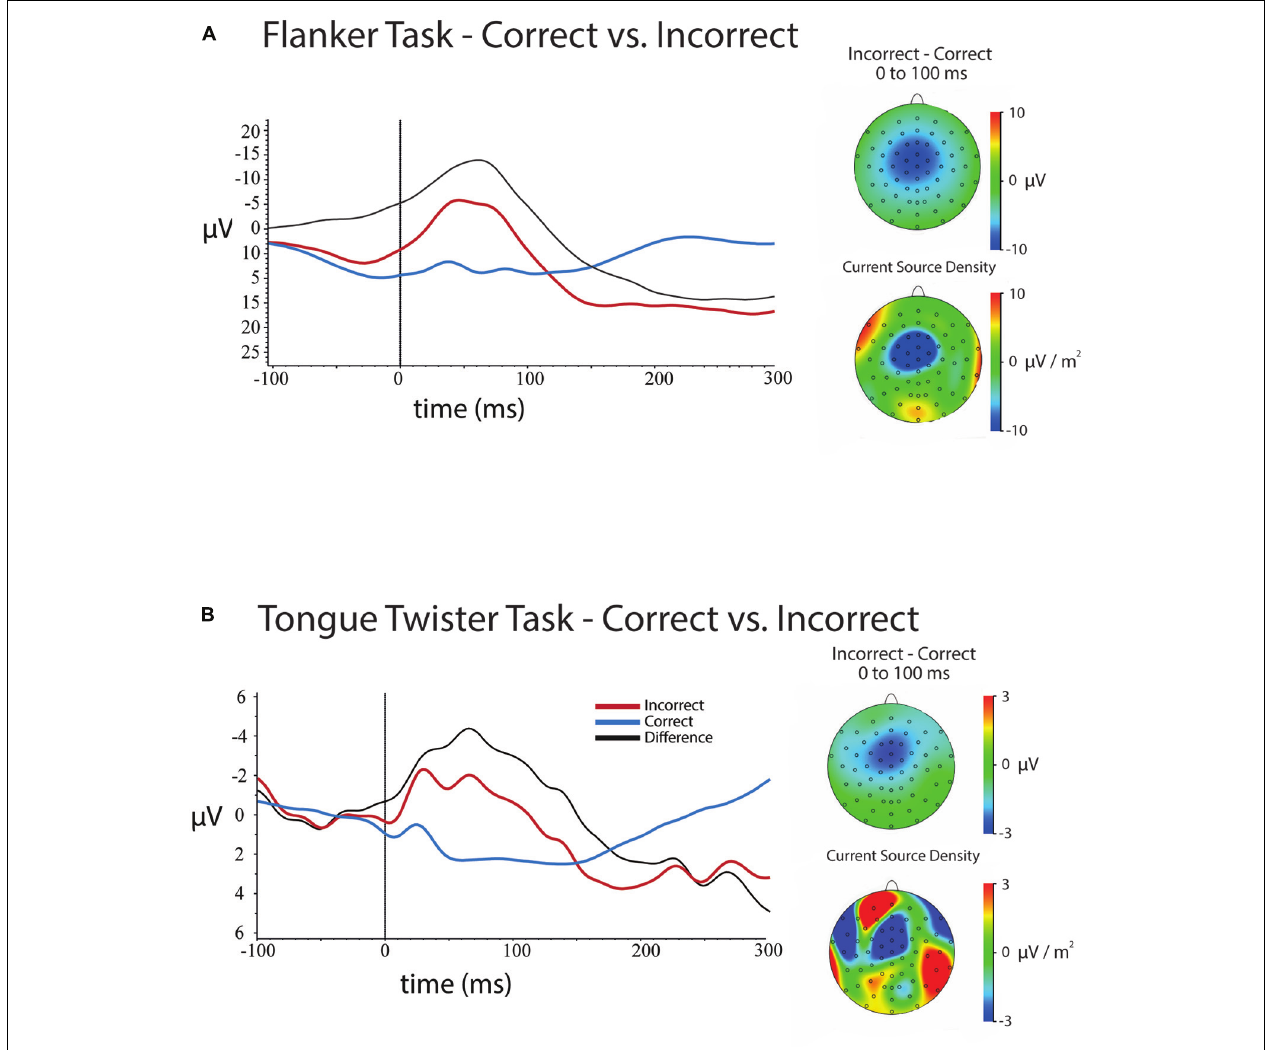
FIGURE 3 | Response-locked ERPs and scalp topographies of differences for both tasks. ERPs are plotted for electrode FCz, and were baseline- corrected − 300 to − 200 ms before response onset. (A) ERPs for errors and correct trials at FCz in the flanker task and the scalp topographies of the mean amplitude (upper) and current source density (lower) differences between